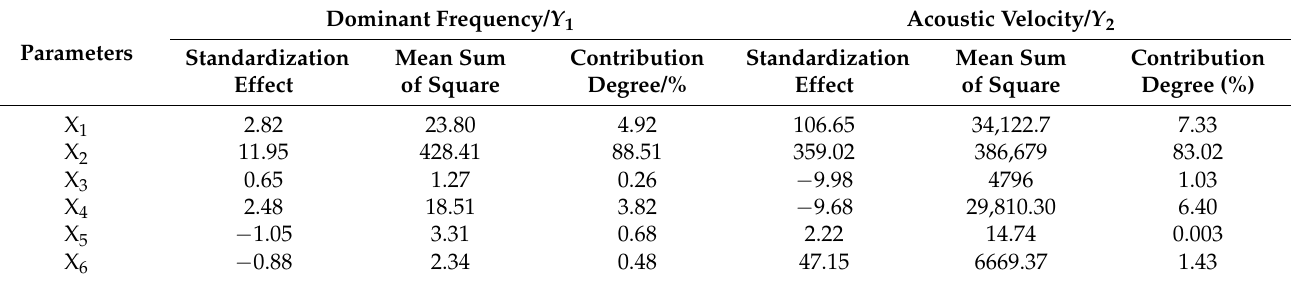
Table 7. The results of the sensitivity analysis.